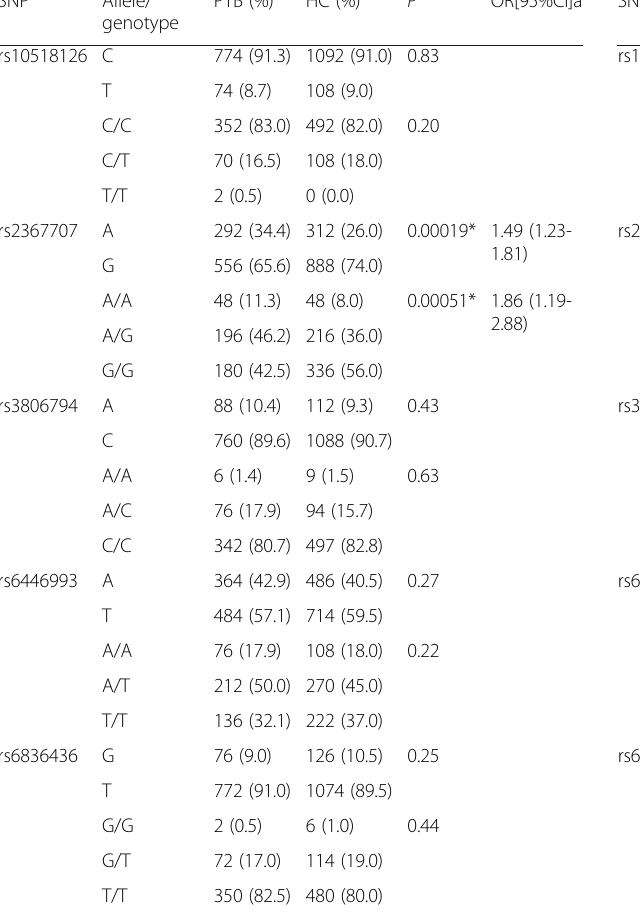
a Adjusted for age and gender from a logistics regression